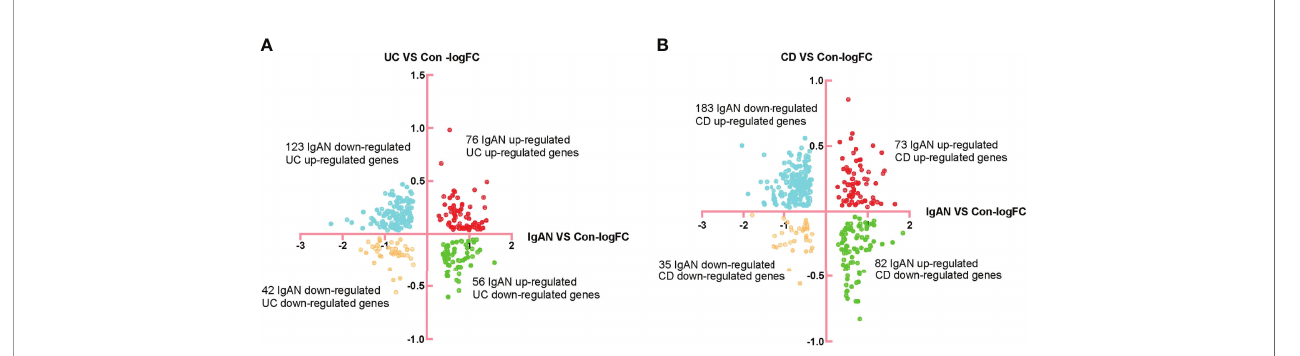
FIGURE 1 | Identi fi cation of DEGs of IgAN, UC, and CD. (A) FC-FC plot of IgAN and UC, there were 76 common up-regulated genes and 42 common down-regulated genes in IgAN and UC. (B) FC-FC plot of IgAN and CD, there were 73 common up-regulated genes and 35 common down-regulated genes in IgAN